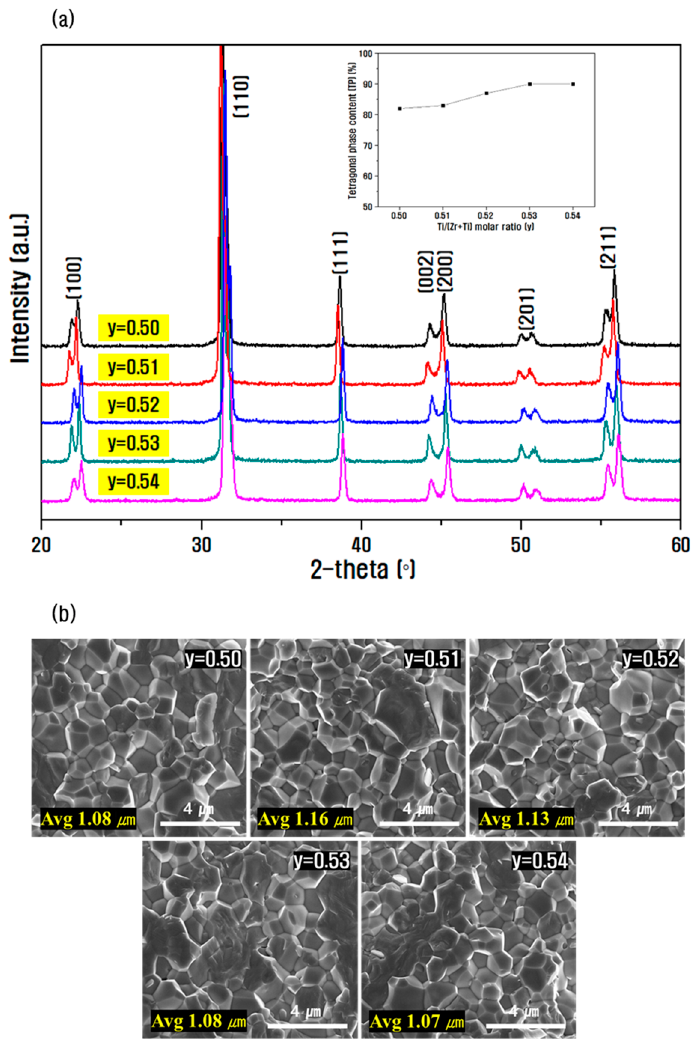
Figure 6. ( a ) X-ray diffraction pattern (inset graph: content change of tetragonal phase) and ( b ) FE-SEM image of fracture surfaces of ceramic according to Zr/Ti ratio in 0.14PZN-0.06PMN- 0.80PbZr 1 − y Ti y ·0.1 wt.% Sb 2 O 3 composition.